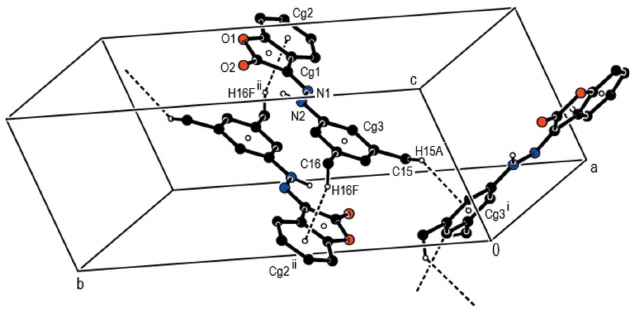
Figure 2 A partial packing view of the title compound, showing the C—H (cid:2)(cid:2)(cid:2) (cid:2) interactions (dashed lines). Only H atoms involved in the interactions and N-bound H atoms are shown for clarity [Symmetry codes: (i) x , (cid:4) y (cid:4) 1